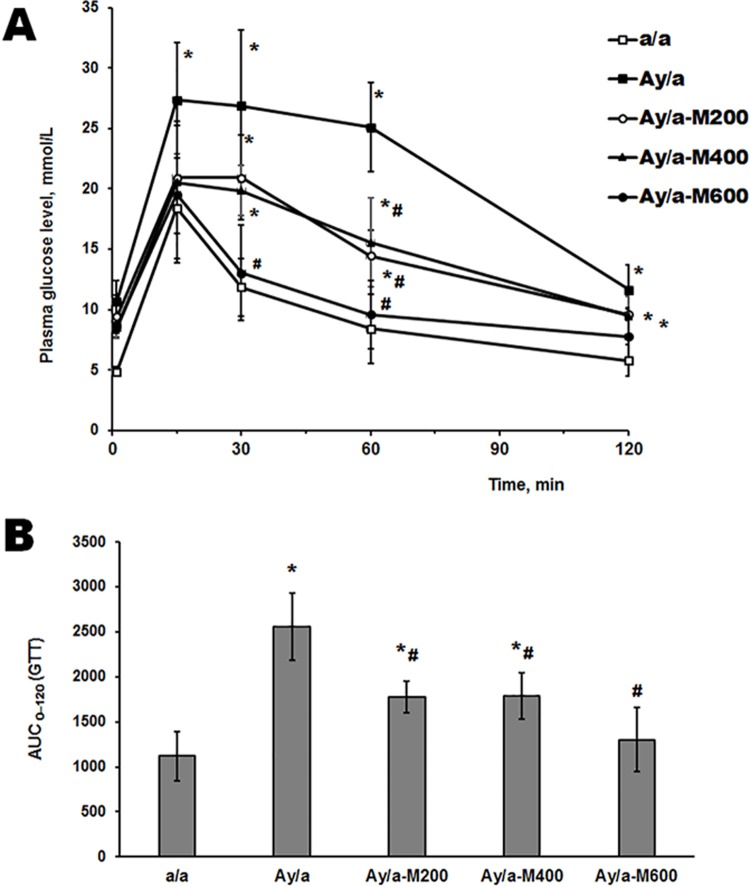
Glucose curves and AUC0-120 in GTT in obese agouti-mice and the effect of metformin treatment.(A) The glucose concentration curves in the glucose tolerance test. (B) The AUC0-120 values for the glucose concentration curves during the time interval from 0 to 120 min. The data are presented as the M ± SD. *—the difference between the control mice and all the studied groups of agouti-mice is significant at P < 0.05; #—the difference between the Group Ay/a and MF-treated agouti-mice is significant at P < 0.05. In each group: n = 5.